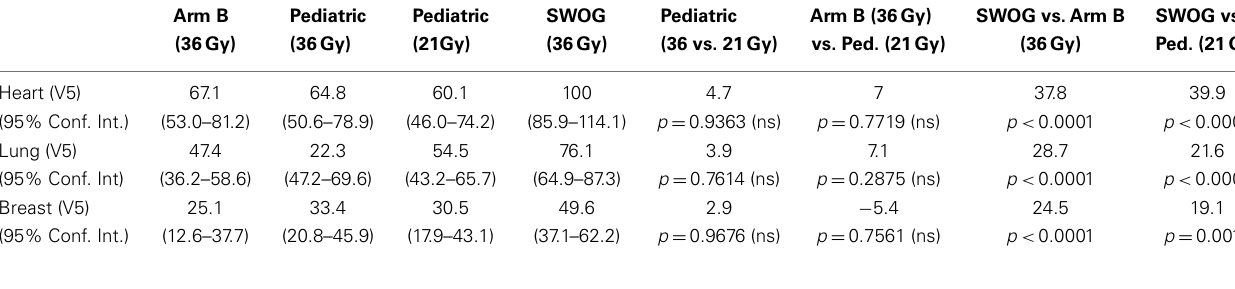
Table 4 | Heart, lung, and breastV5 analysis by protocol specified treatment prescription